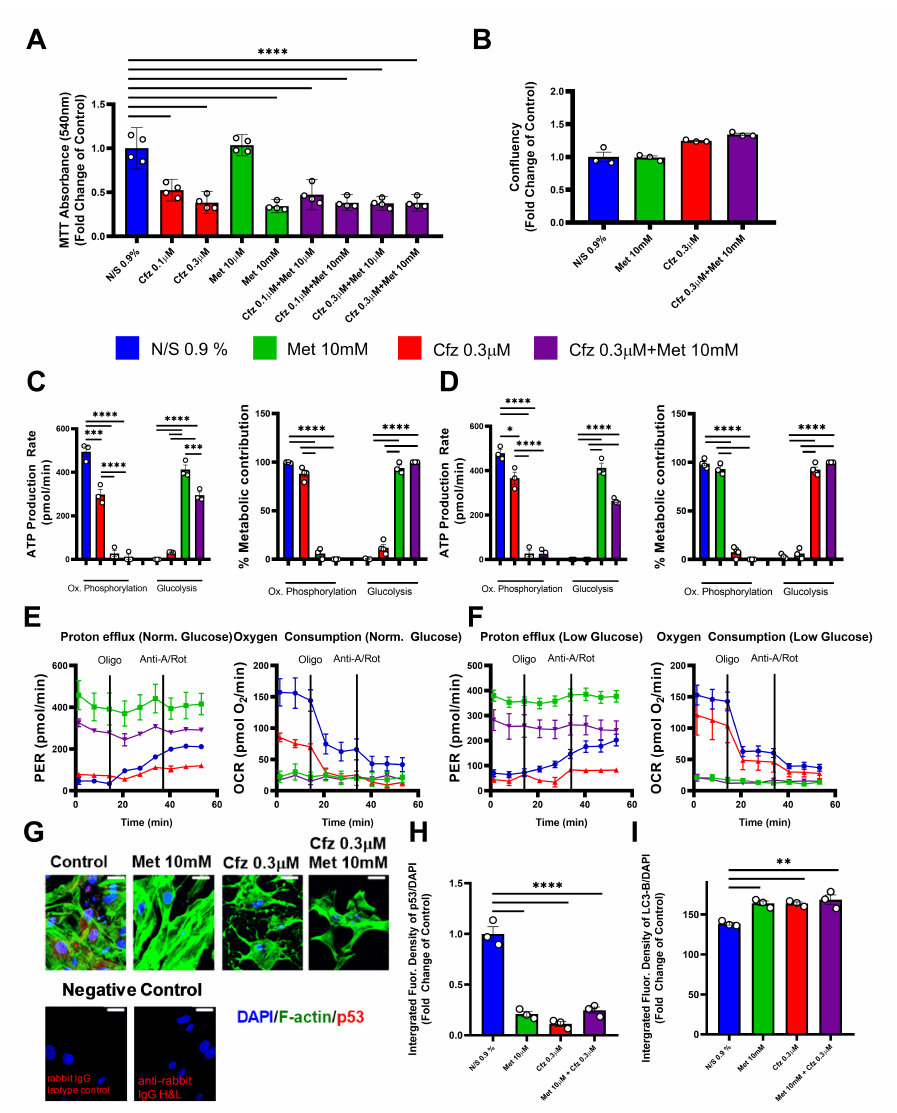
Figure 6. Carfilzomib and metformin induce cytotoxicity in primary murine vascular smooth muscle cells (prmVSMCs) in vitro. Graphs of ( A ) MTT absorbance (540 nm) expressed as the fold change of the control (**** p < 0.001; one way ANOVA, Tukey’s multiple comparison test; n = 4 per group), ( B ) cellular confluency expressed as the fold change of the control ( n = 3 per group), ( C ) ATP production rate (pmol / min) and % metabolic contribution under conditions of normal glucose (10 mM) originating from oxidative phosphorylation and glycolysis (*** p < 0.005, **** p < 0.001; one way ANOVA, Tukey’s multiple comparison test; n = 3 per group) and ( D ) ATP production rate (pmol / min) and % metabolic contribution under conditions of low glucose (1 mM) originating from oxidative phosphorylation and glycolysis (* p < 0.05, **** p < 0.001; one way ANOVA, Tukey’s multiple comparison test; n = 3 per group). Time-course graphs of the proton e ffl ux rate (PER) and oxygen consumption rate (OCR) under the conditions of ( E ) normal glucose (10 mM) and ( F ) low glucose (1 mM), as studied with ATPase inhibitor oligomycin (Oligo) and cytochrome c reductase inhibitor antimycin-a (Anti-A) and complex I inhibitor rotenone (Rot). ( G ) Merged immunofluorescence confocal images of prmVSMCs stained against F-actin (Phalloidin, green), p53 (red) and DAPI (blue) as well as the negative control for the staining (rabbit isotype control and anti-rabbit IgG H&L secondary antibody). Graphs of ( H ) integrated fluorescence density of p53 / DAPI expressed as the fold change of Normal Saline (NS) 0.9%, serving as the control vehicle and ( I ) total fluorescence intensity of LC3B / DAPI as measured in the automated microscope per well (mean total fluorescence intensity of individual VSMCs in the well; ** p <